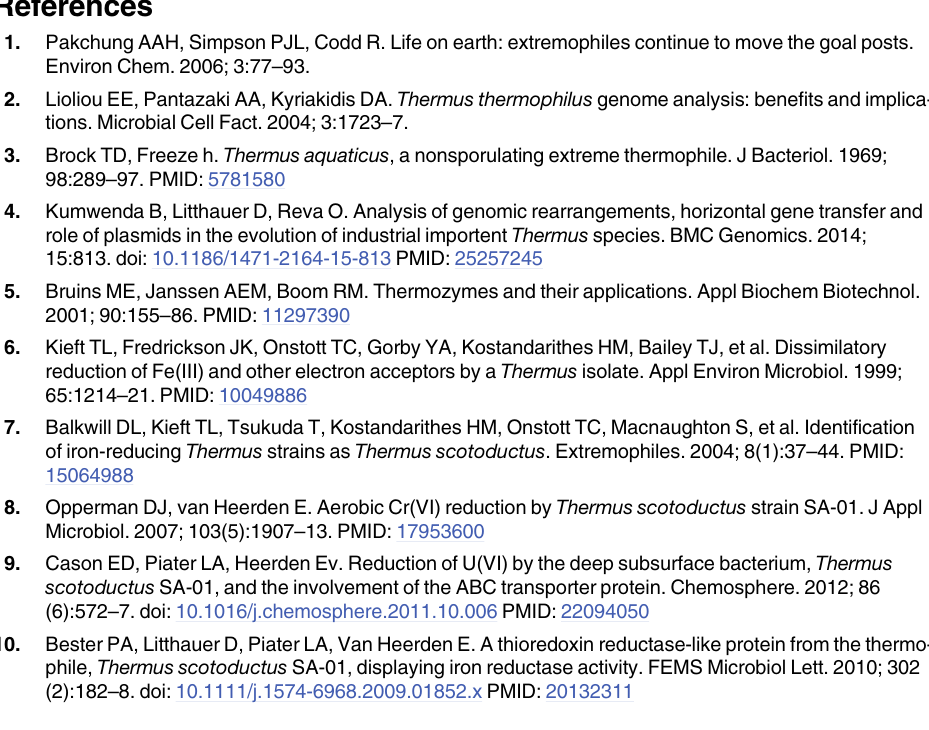
S2 Table. MIQE checklist. S3 Table. NormFinder intra- and intergroup variances under aerobic and anaerobic growth conditions. S4 Table. NormFinder intra- and intergroup variances during anaerobic growth with dif- ferent terminal electron acceptors. S5 Table. NormFinder intra- and intergroup variances during aerobic growth with oven or microwave heating. S6 Table. NormFinder intra- and intergroup variances under all growth conditions.